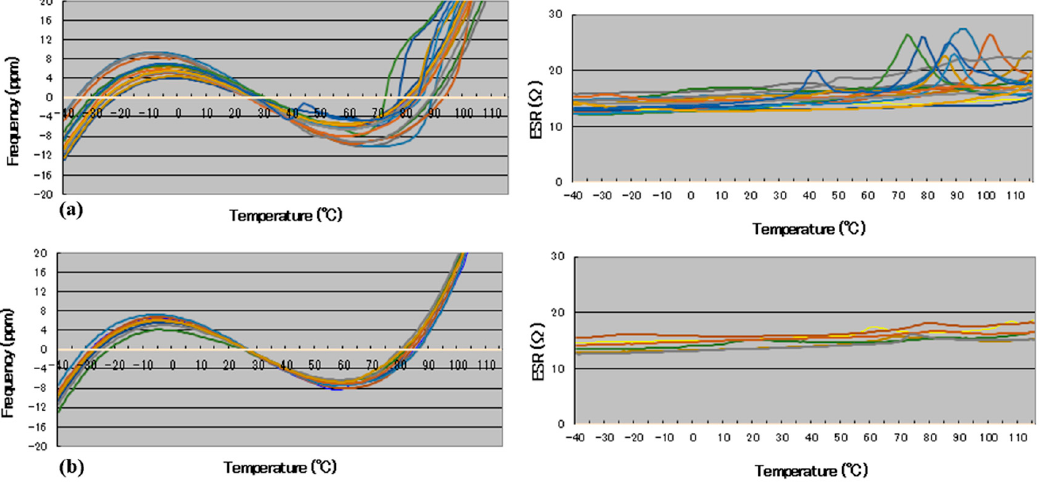
Figure 8. Temperature–frequency/resistance characteristic curves: ( a ) the 6th group; ( b ) the 7th group.